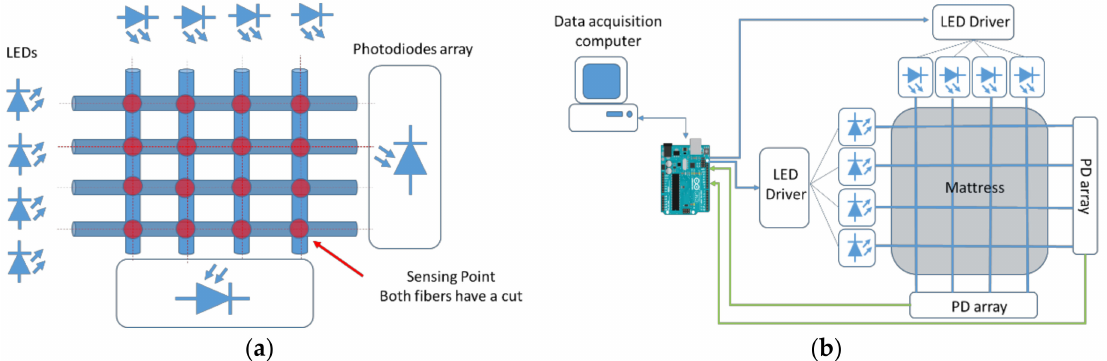
Figure 3. ( a ) Schematic representation of the fiber matrix; and ( b ) sensor implementation: the arrows represent the communication between the computer, the board and the electronic components of the interrogation